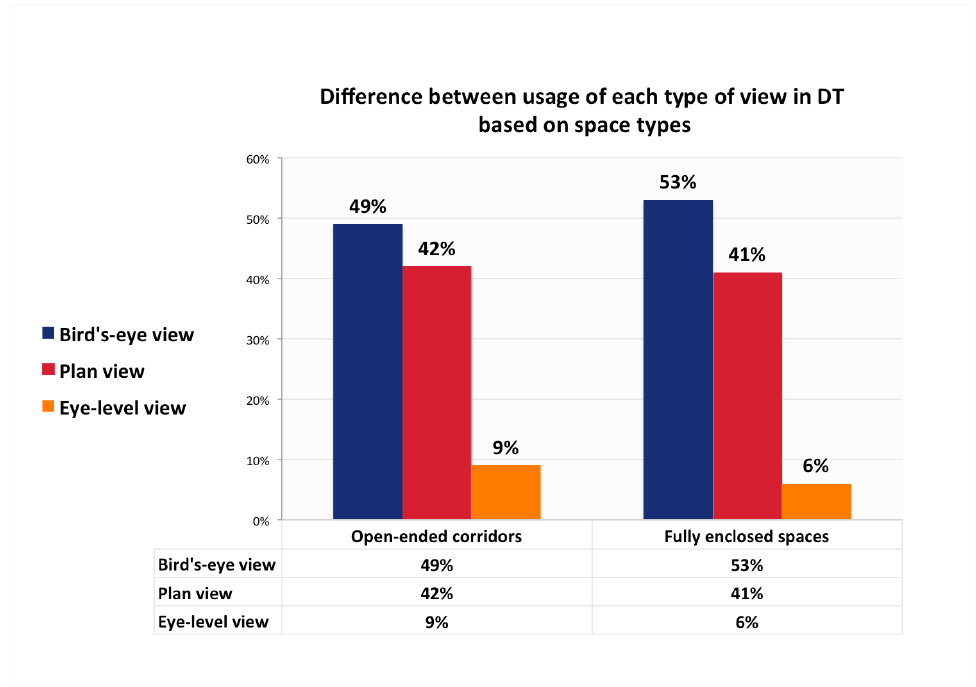
Figure 7. Comparison of view usage patterns in the DT system, based on space type.